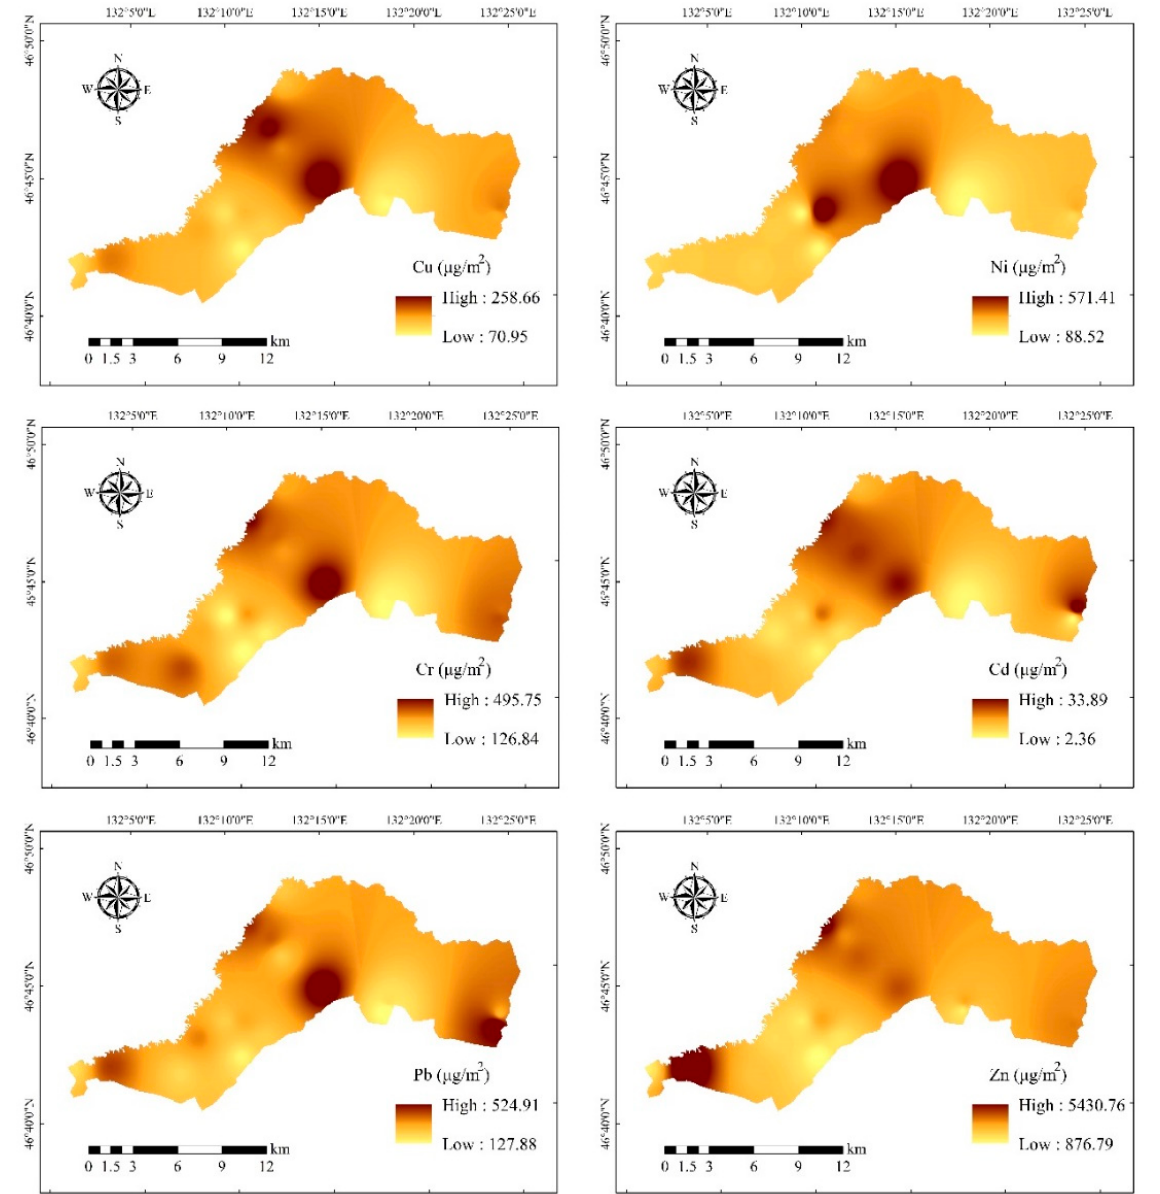
Figure 5. Spatial distributions of Cu, Ni, Cr, Cd, Pb, and Zn residues in snow cover from Qixing River